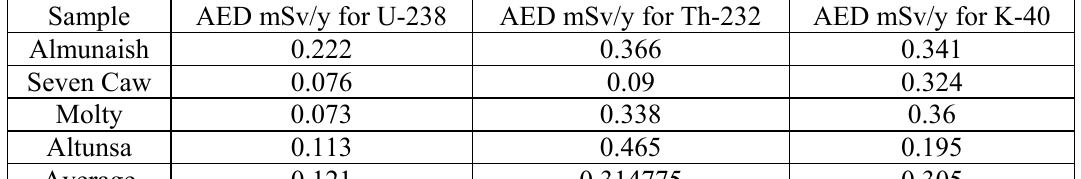
Table 2: The annual effective dose in all powdered milk samples.